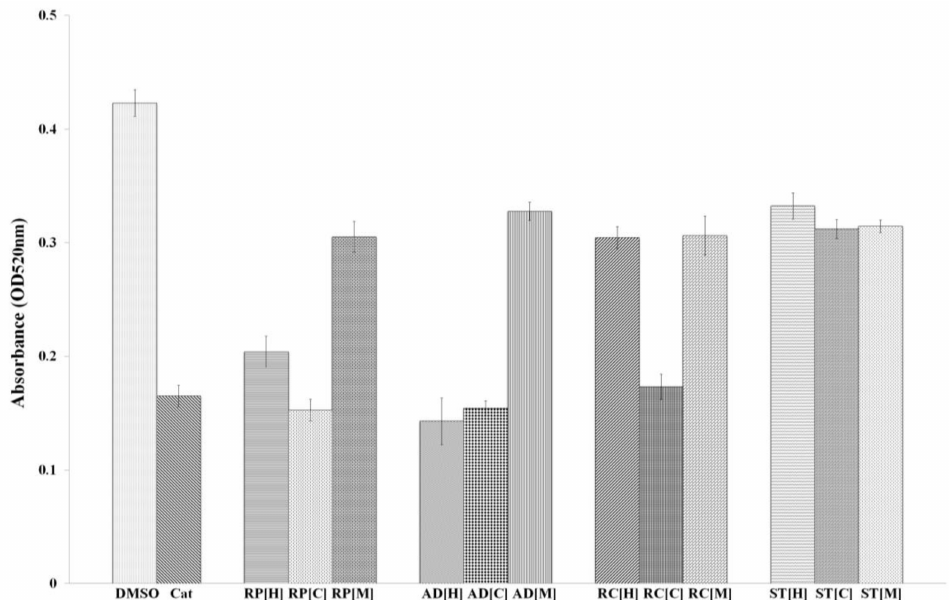
Figure 4. The inhibition of pyocyanin production by hexane [H], chloroform [C] and methanol [M]-extracted plant samples. P. aeruginosa PAO1 incubated with DMSO and catechin (Cat) served as negative and positive controls, respectively. RP, AD, RC and ST correspond to the plant extracts from Poria cum R. pini , A. dahurica , R. cibotii and S. tenuifolia , respectively, at the final concentration of 1 mg/mL. A. dahurica in hexane extract shows the strongest inhibition on the production of pyocyanin while S. tenuifolia shows the weakest effect among all the plant